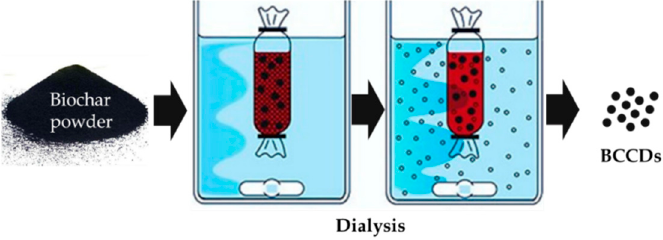
Figure 2. Dialysis purification of BC for the isolation of BCCDs. Dialysis purification of suspended BC allows for cutting out particles of different molecular size, isolating them inside or outside the membrane. Dialytic procedure is the unavoidable stage for any CDs production, and could be coupled with other approaches such as a chromatographic one for further refining of the CDs size distribution [56,57]. Size distribution is strongly related to all the CDs features such as PL [58] and biological exploits